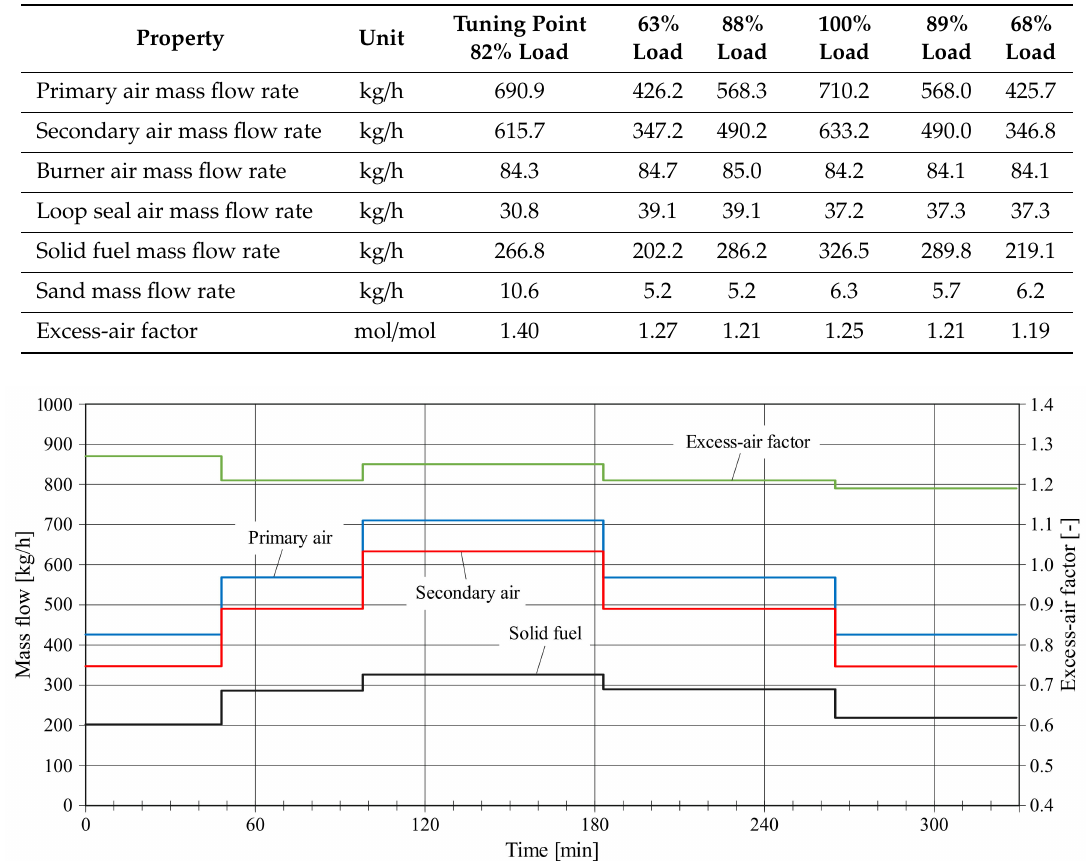
Figure 3. Schematic presentation of test conditions during part-load